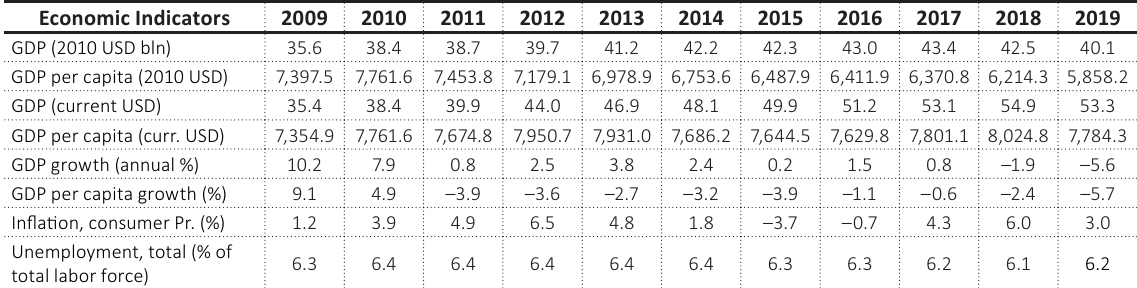
Table 1. Economic outlook of Lebanon for 2009–2019 Economic